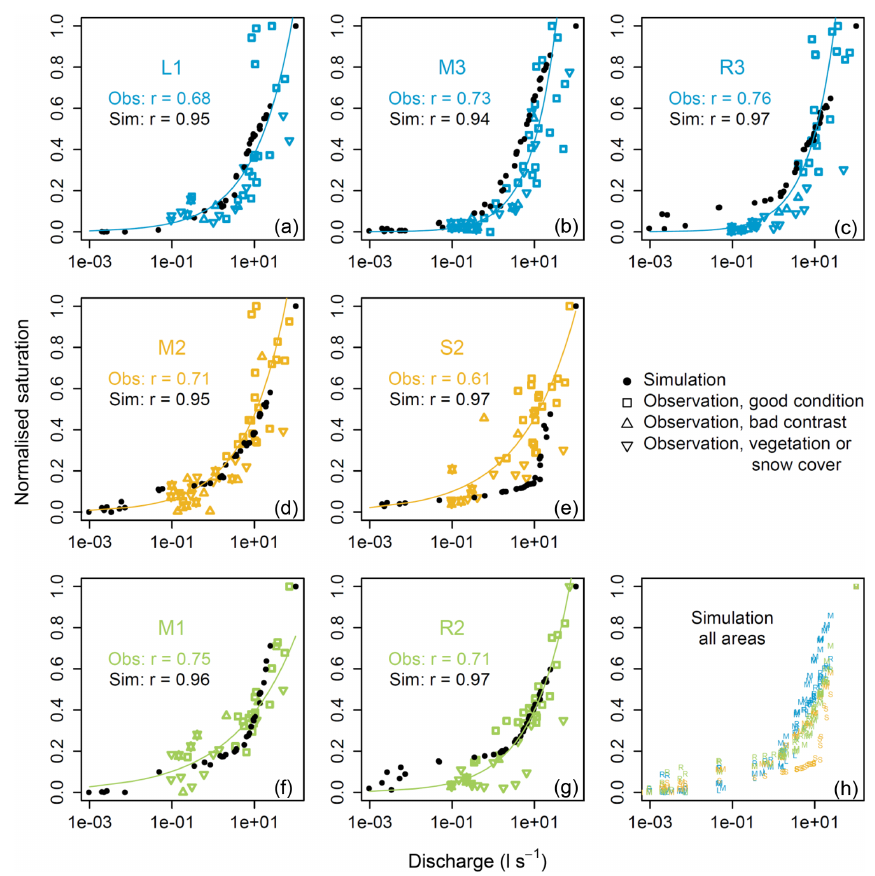
Figure 6. Observed and simulated relationships and Kendall correlations between normalised surface saturation and discharge at the catch- ment outlet SW1 for the seven investigated riparian areas along (a) left (L1), (b, d, f) middle (M1–M3), and (c, g) right (R2, R3) tributary and (e) the central stream (S2). Colours correspond to the colours of the icons in Fig. 1 and represent the different categories of riparian areas. Observations that were derived from TIR images with a poor temperature contrast or with influences of vegetation and snow cover are deemed less reliable and are indicated with triangles. Simulated data points correspond to the times of observations (cf. Fig. 5); the plotted amount of data points with low and high discharge values differs between the observations and simulations due to mismatches between ob- served and simulated discharge at these times (cf. Fig. 5). Solid lines are power law curves fitted to the observation data, excluding data taken during rainfall or rising discharge. Note that discharge is plotted in a logarithmic scale, showing relationships of convex shapes although power law exponents are <1 for all areas. See Fig. S2 for plots with non-logarithmic abscissae and ordinates. To facilitate the comparison between the seven areas, the (h) simulated data points from all seven areas are shown with the different colours and letters of the respective areas in the panel on the bottom